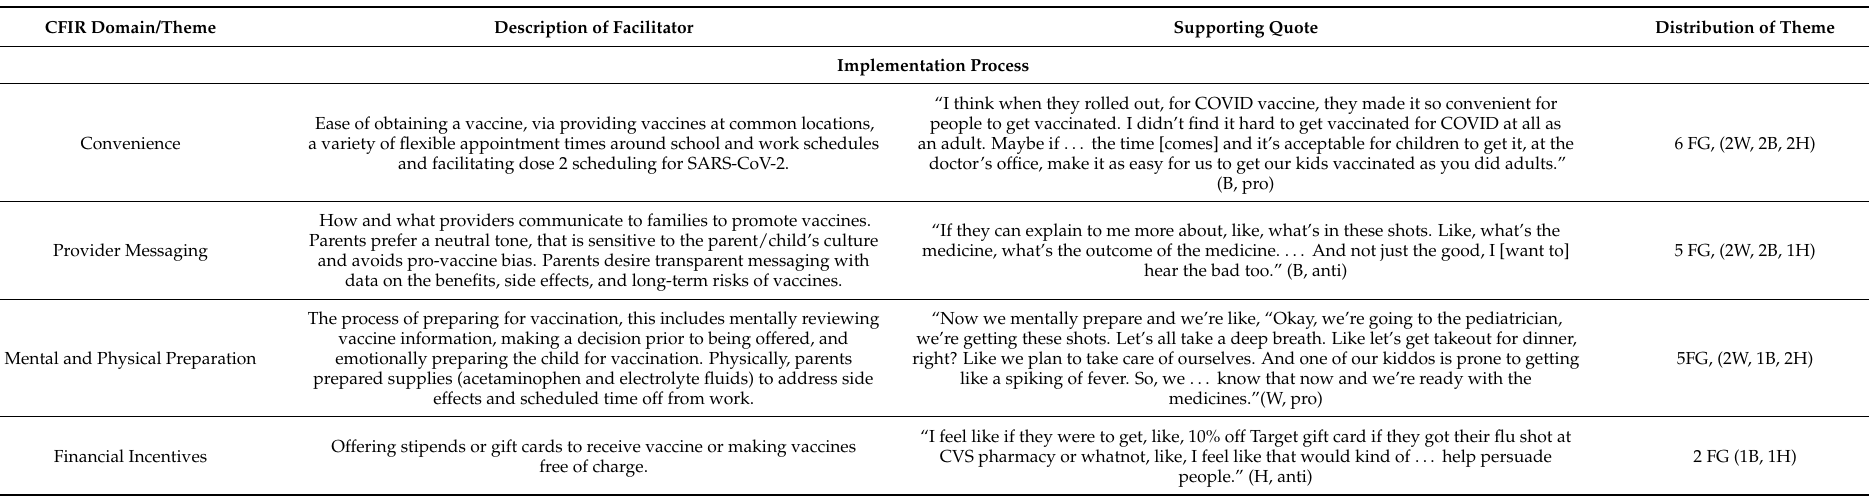
Table A5. Facilitator Themes to Influenza and SARS-CoV-2